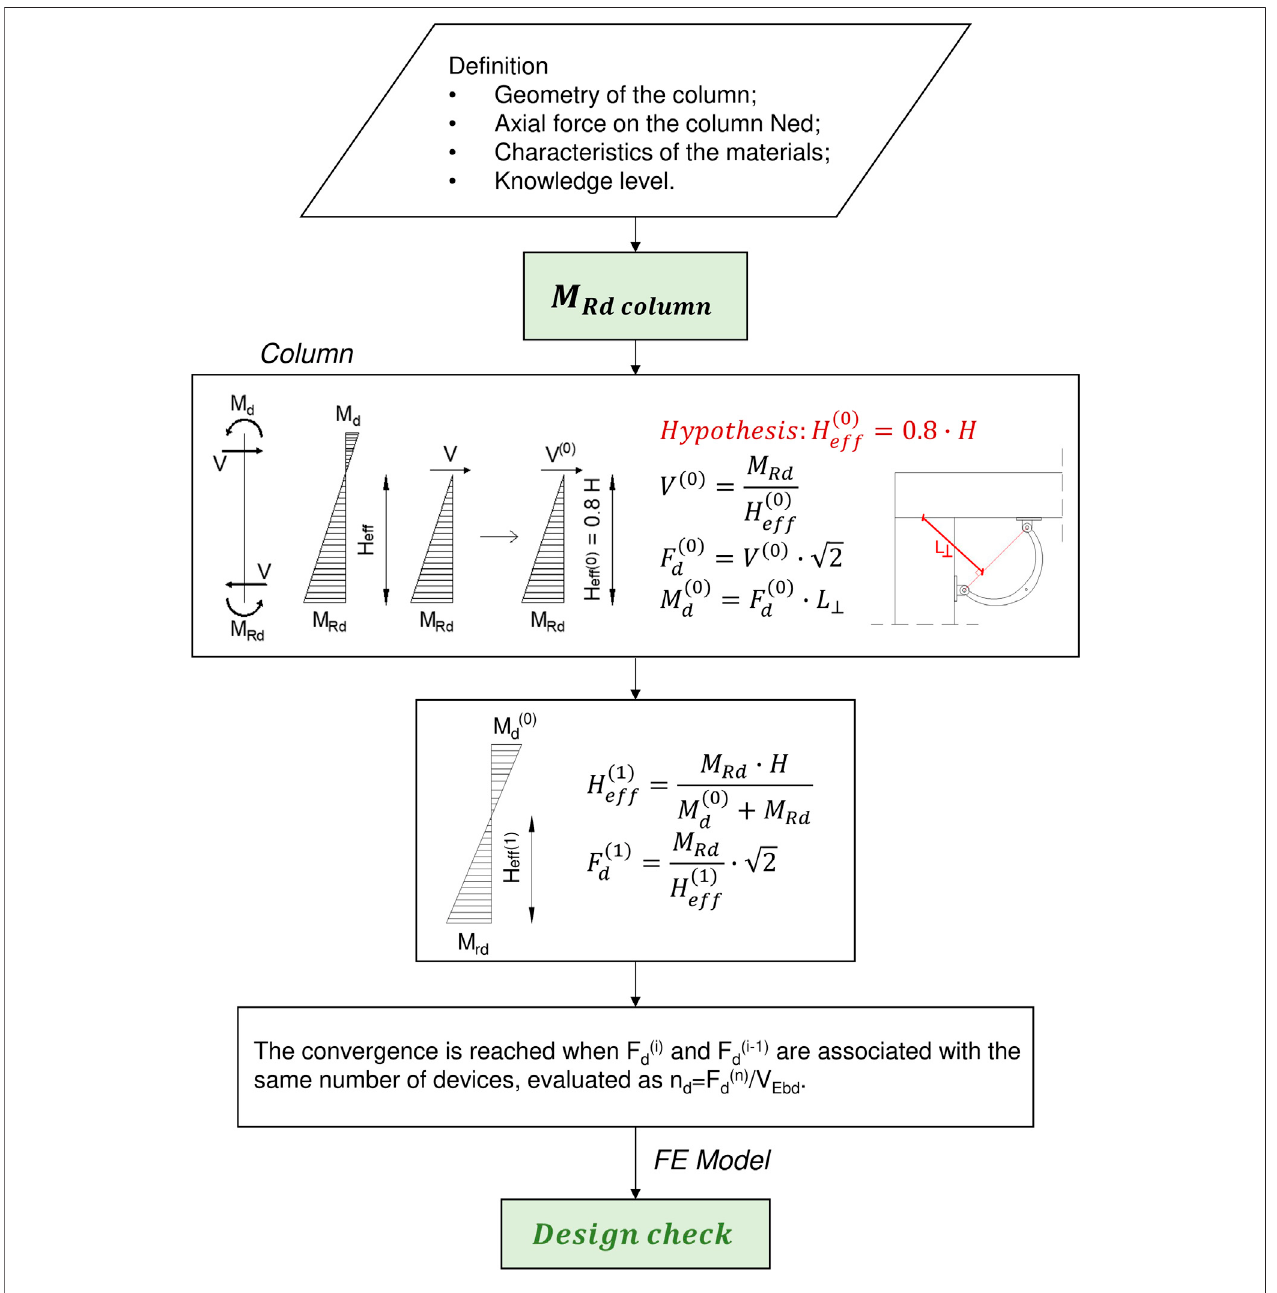
FIGURE 9 | Flow chart of the design procedure.Note: L ⊥ is the distance between the line passing through the device connections and the beam rotation point at the beam-to-column interface.